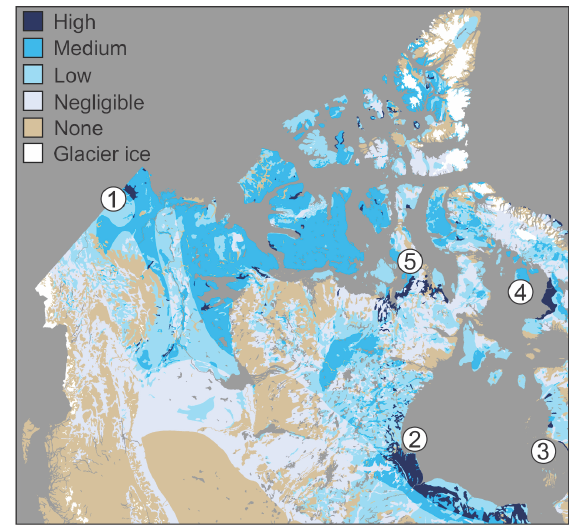
Figure 6. Modelled abundance of segregated ice. Old Crow Basin (1) is characterized by widespread excess ice in fine-grained lacustrine sediments and an abundance of shallow thermokarst lakes. Within the Hudson Bay Lowlands (2), areas with high segre- gated ice abundance include extensive raised peat plateaus. Lithal- sas are widespread in raised marine sediments at Umiujaq (3). The Great Plain of the Koukdjuak (4) and southern Boothia Penin- sula (5) also include fine-grained uplifted marine sediments, and shallow thaw lakes are abundant in both